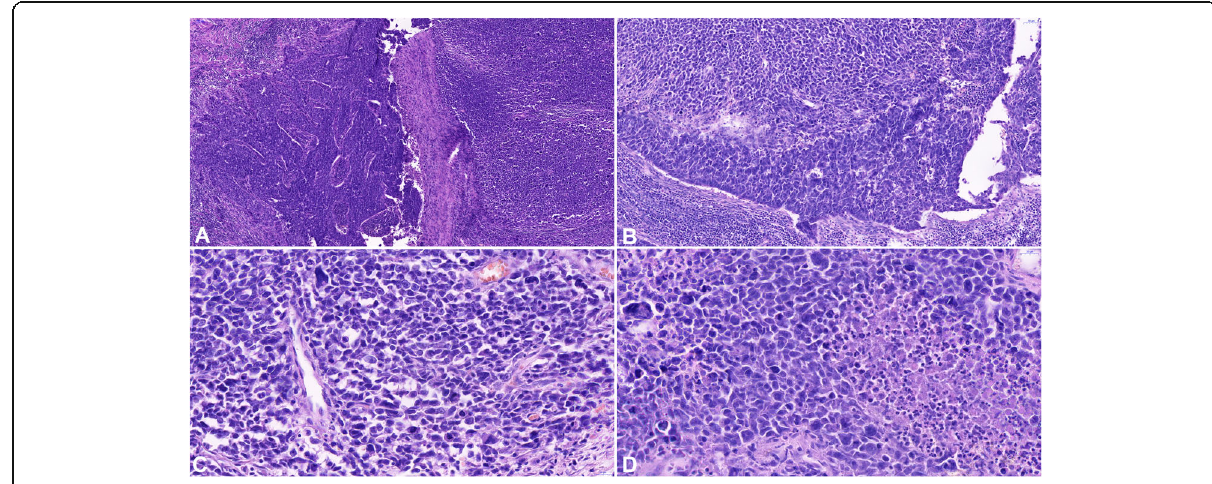
Fig. 2 Scans of histological slides stained with hematoxylin-eosin, showing biphasic malignant tumor of the uterine cervix, a squamous epithelioid part in the left, sarcomatoid part in the right, 7,1x b direct transition between sarcomatoid (up) and epithelioid (bottom) tumor components, 18,2x c detail of the sarcomatoid part with highly atypical spindle cells and bizarre cells, 52,7x, d and with necrosis,